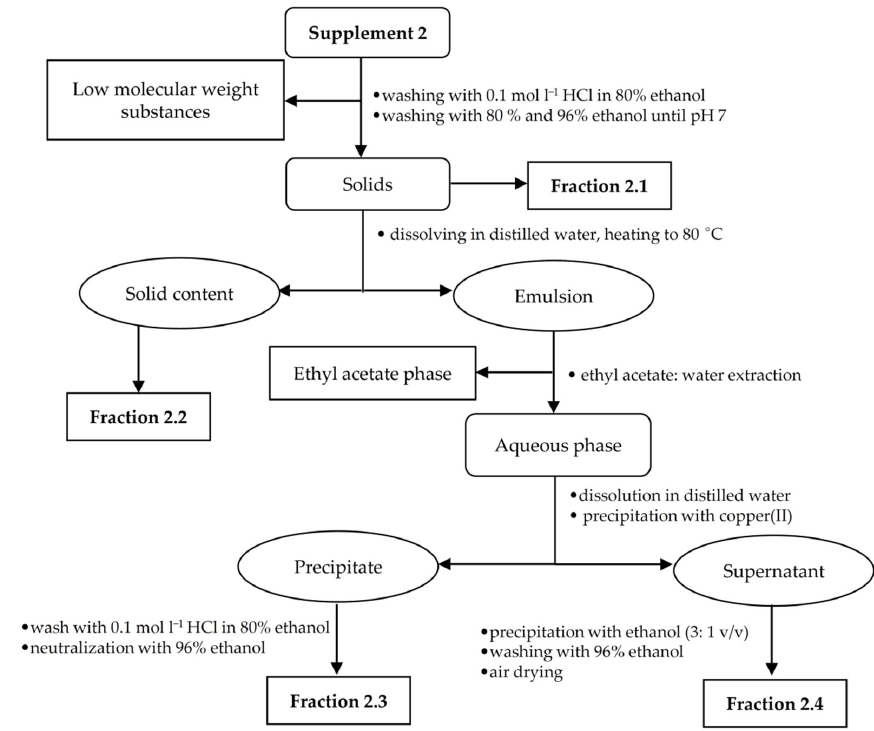
Figure 2. Isolation scheme for supplement 2.